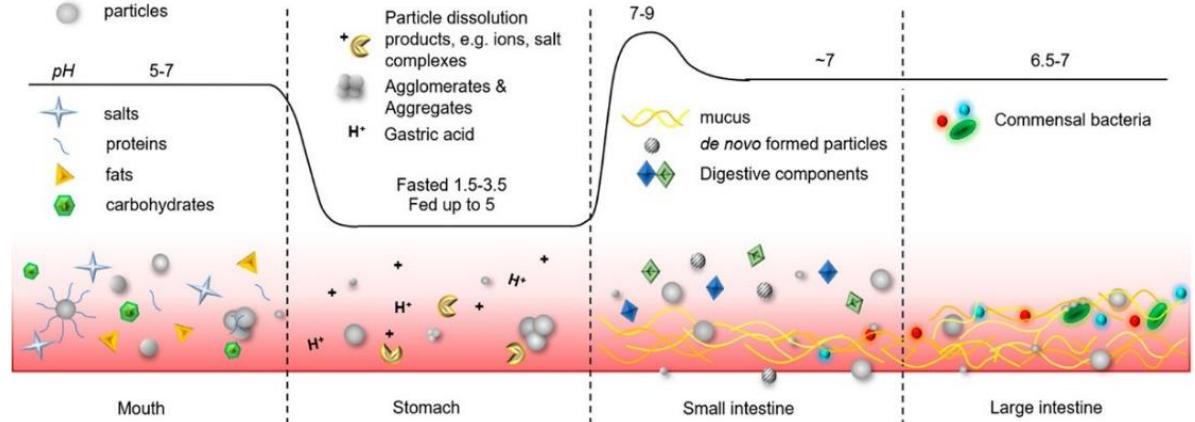
Figure 2. Oral administration can lead the nanoparticles to intestinal epithelial cells and load thera- peutic drugs to enter epithelial cells, which are not affected by other substances in the gastrointesti- nal